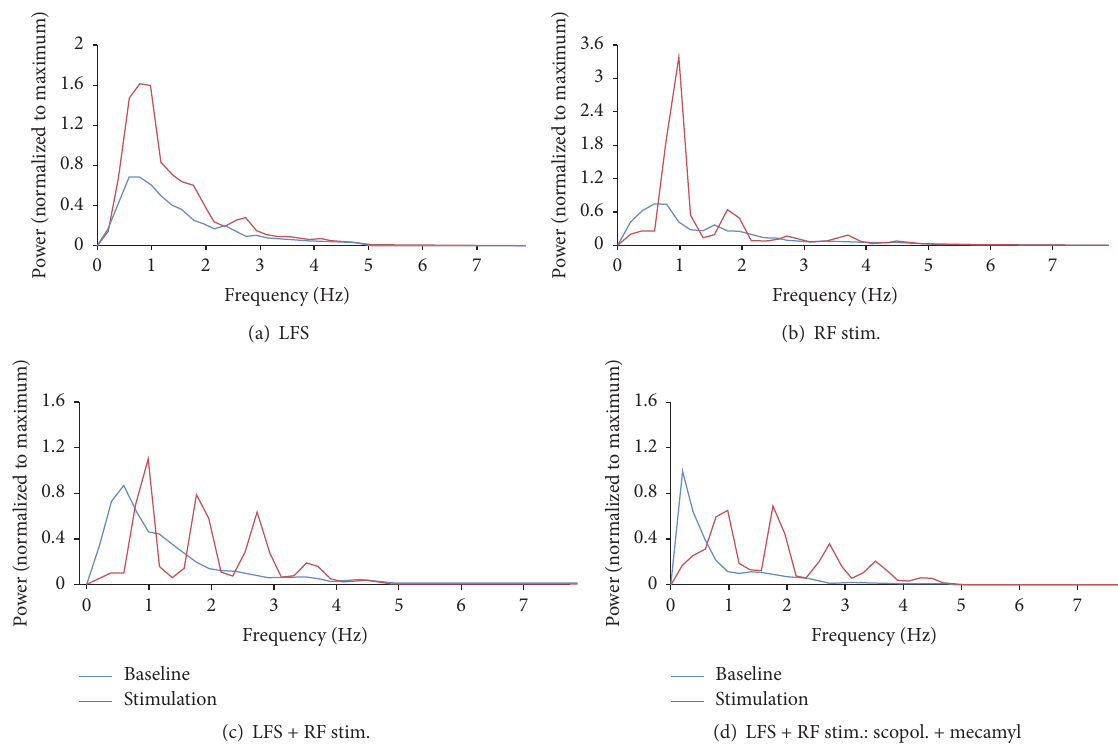
Figure 5: Averaged power spectra for ECoG activity (band-pass filtered between 0.1 and 5 Hz) recorded in V1 of urethane-anesthetized rats. (a) Baseline (prestimulation) ECoG activity showed prominent slow wave activity with peak power between 0.6 and 0.8 Hz. Application of LFS to the LGN enhanced power between 0.6 and 2Hz. (b) RF stimulation alone or (c) paired LFS + RF stimulation suppressed very low- frequency ( ∼ 0.6Hz) power, strongly enhanced power around 1Hz, and resulted in the appearance of power peaks at ∼ 1.8, 2.7, and 3.5 Hz. (d) Rats treated with a combination of scopolamine and mecamylamine (scopol., 10mg/kg + mecamyl., 5mg/kg) continued to exhibit the novel power peaks elicited by LFS + RF stimulation. Power spectra are group averages ( n ’s for all groups, the same as above) and were calculated for 30-second epochs recorded prior to and during delivery of the stimulation protocol. For each rat, power was normalized to the peak power present in the baseline ECoG